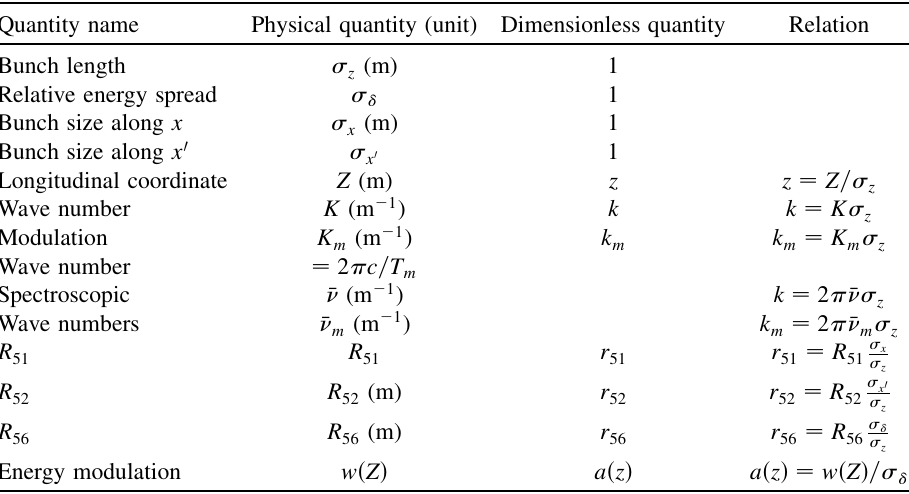
TABLE I. Links between physical and dimensionless variables used in the paper. Bunch sizes are rms values just before laser-electron bunch interaction.